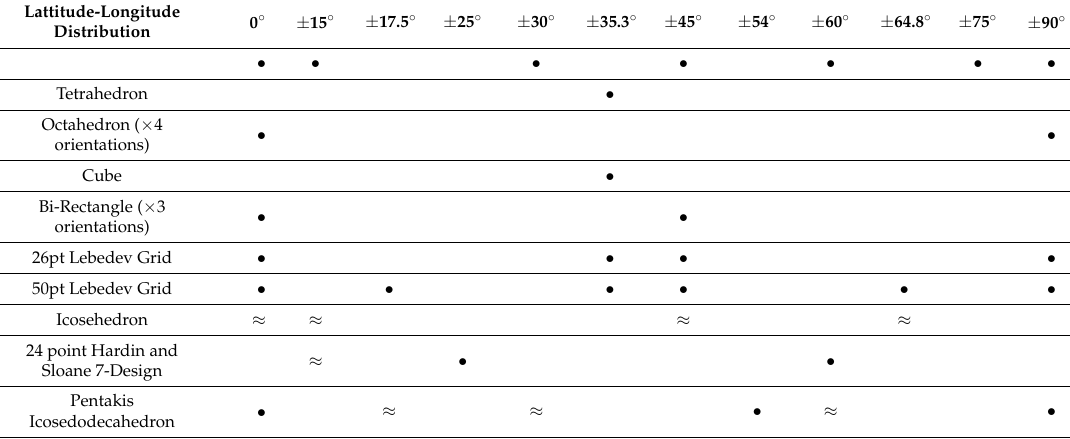
Table 3. Distributions considered for HRTF measurement and their corresponding elevations. The black dots indicate the affiliation of a particular elevation angle with a particular configuration. Approximations are indicated by the symbol ≈ . Note that elevations correspond to the vertices (not faces) of each